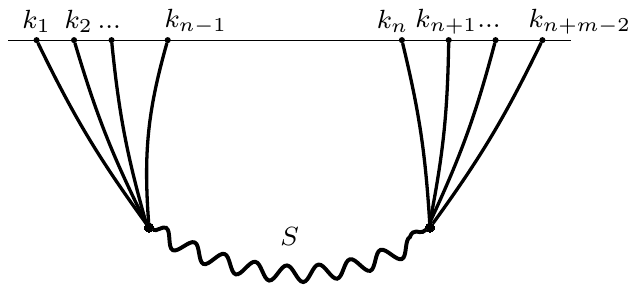
Figure 1 . A single exchange diagram with external scalars exchanging a generic